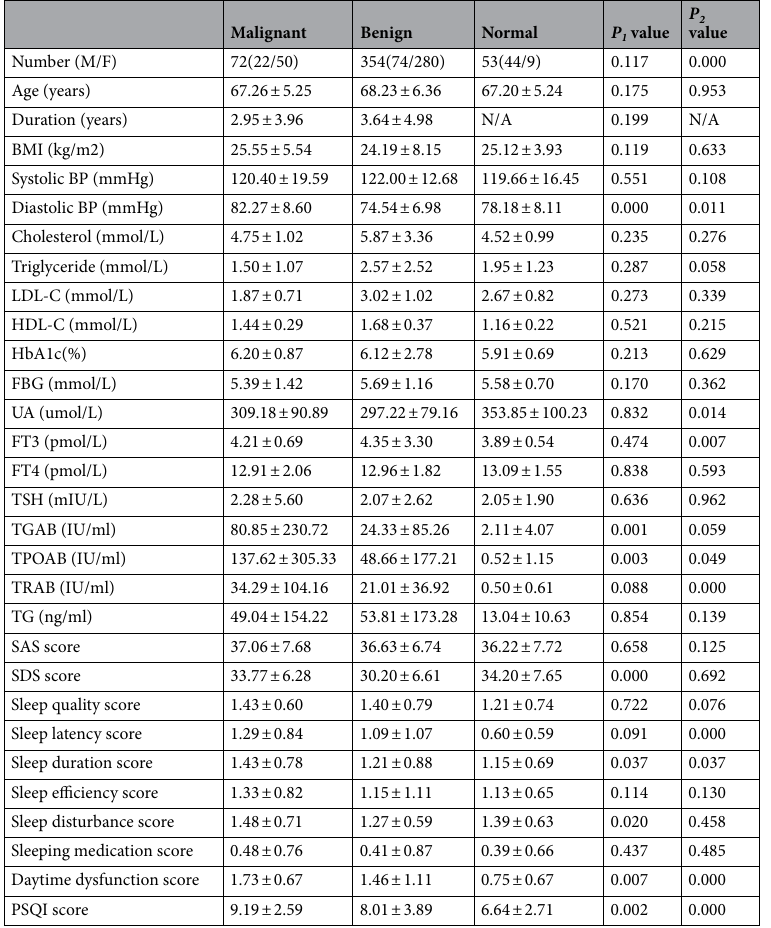
Table 1. Clinical characteristics and sleep quality of participants in thyroid malignant group, benign nodule group and normal group. Data expressed as means ± SD or number. P 1 value was a comparison between thyroid malignant and benign groups. P 2 value was a comparison between thyroid malignant and normal groups. BMI body mass index; BP blood pressure; LDL-C low-density lipoprotein cholesterol; HDL-C high- density lipoprotein cholesterol; HbA1c glycosylated hemoglobin; FBG fasting blood glucose; UA uric acid; SAS self-rating anxiety scale; SDS self-rating depression scale; PSQI Pittsburgh Sleep Quality Index; N/A not available.